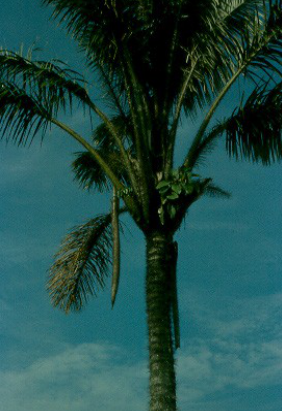
Figure 23. Palm tree, Astrocaryum chambira , in Peruvian Amazon, where parthenogenetic female of Tityus metuendus was